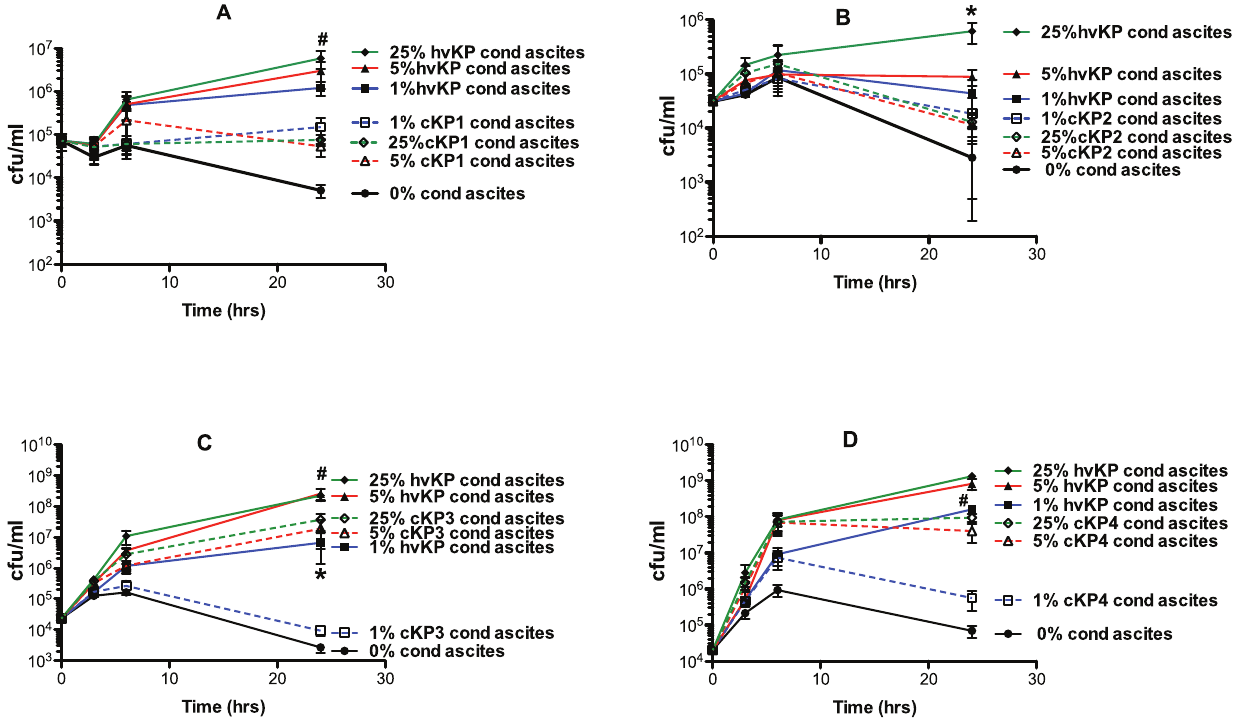
Figure 9. hvKP1 generated conditioned ascites is a more potent enhancer of growth/survival in ascites of cKP1-4 than cKP1-4 generated conditioned ascites. The growth of cKP1-4 was assessed at 0, 3, 6, and 24 hours in human ascites (batch 2) that was heated at 56 u C for 30 minutes ( D 56 u C) and supplemented with 0%, 1%, 5%, or 25% of hvKP1 or cKP1-4 generated conditioned D 56 u C ascites. Panel A: cKP1; there was a trend for increased growth and/or survival of cKP1 when ascites was supplemented with 25% hvKP1-generated conditioned ascites compared to 25% cKP1-generated conditioned ascites ( # P . 0.05/3 but , 0.05). Panel B: cKP2; the growth and/or survival of cKP2 was significantly increased when ascites was supplemented with 25% hvKP1-generated conditioned ascites compared to 25% cKP2-generated conditioned ascites (*P , 0.05/3). Panel C: cKP3; the growth and/or survival of cKP3 was significantly increased when ascites was supplemented with 1% hvKP3-generated conditioned ascites compared to 1% cKP3-generated conditioned ascites (*P , 0.05/3) and there was a trend for increased growth and/or survival of cKP1 when ascites was supplemented with 5% and 25% hvKP1-generated conditioned ascites compared to 5% and 25% cKP1-generated conditioned ascites ( # P . 0.05/3 but , 0.05). Panel D: cKP4; there was a trend for increased growth and/or survival of cKP4 when ascites was supplemented with 1% hvKP1-generated conditioned ascites compared to 1% cKP4-generated conditioned ascites ( # P . 0.05/3 but , 0.05). Data are Mean 6 S.E.M.; N=4.